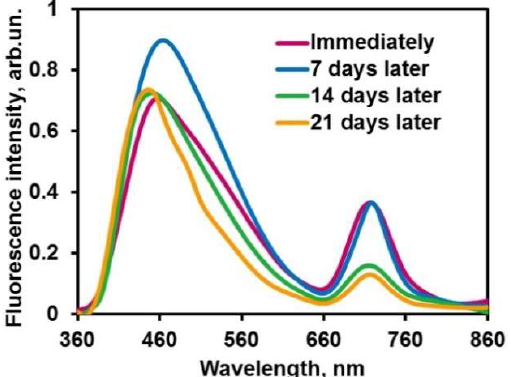
Figure 8. Effect of storage time on the emission spectra of the aqueous supension of maleated chitosan–PHMG–ceftriaxone–dye containers (excited at 345 nm).